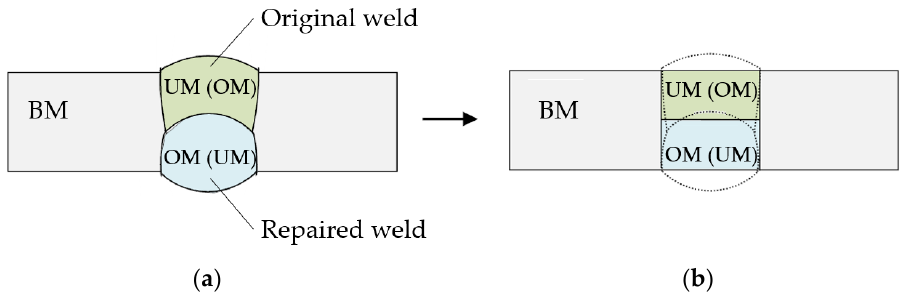
Figure 1. Idealization of repaired I-shaped butt-welded joint: ( a ) heterogeneous welded joint; ( b ) idealized heterogeneous welded joint.